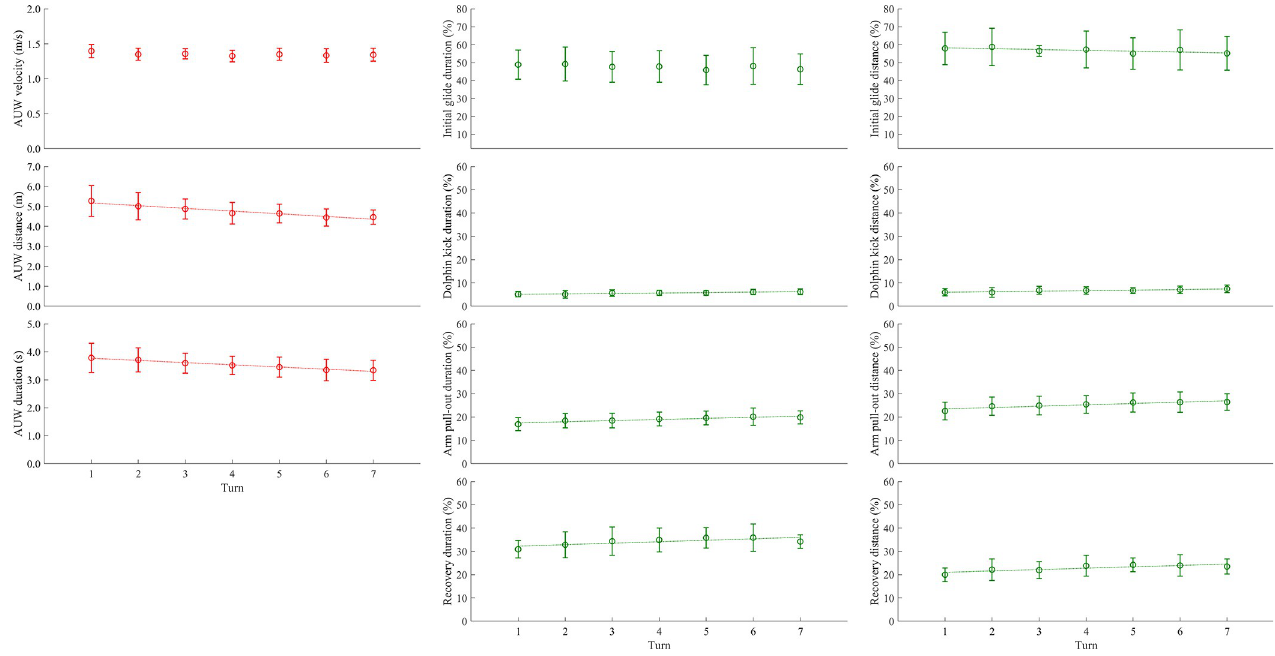
Fig 5. Absolute active underwater (AUW) velocity, distance and duration, as well as the relative duration and distance in each limb motion. Graphs with a linear trend line and a regression equation represent the variables that had a significant lap effect in the linear mixed model analysis.